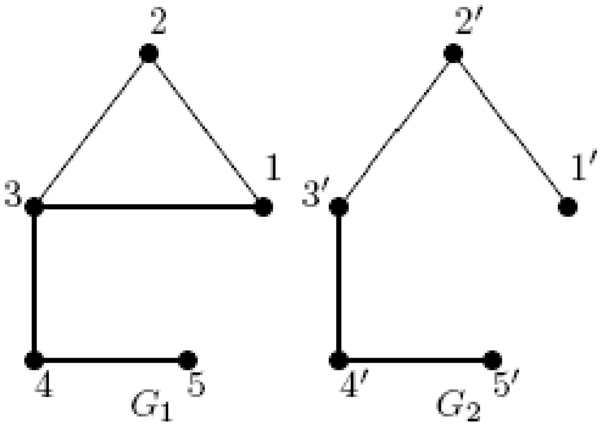
MCIS of two graphs. For G1 and G2, the maximum common induced subgraph of them contains four vertices, and the maximum common edge subgraph of them involves five vertices.